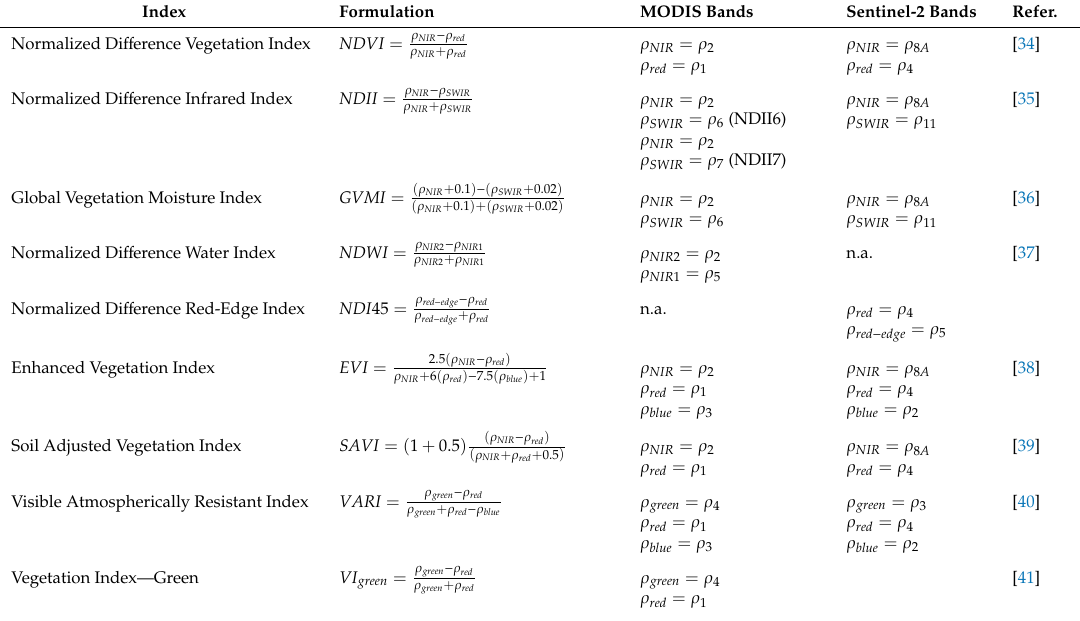
Table 1. Spectral indices obtained from MODIS and Sentinel-2 data. ρ x is the reflectance in band x; NIR, near-infrared; SWIR, short wave infrared; n.a., not applicable. Index Formulation MODIS Bands Sentinel-2 Bands Refer. Normalized Di ff erence Vegetation